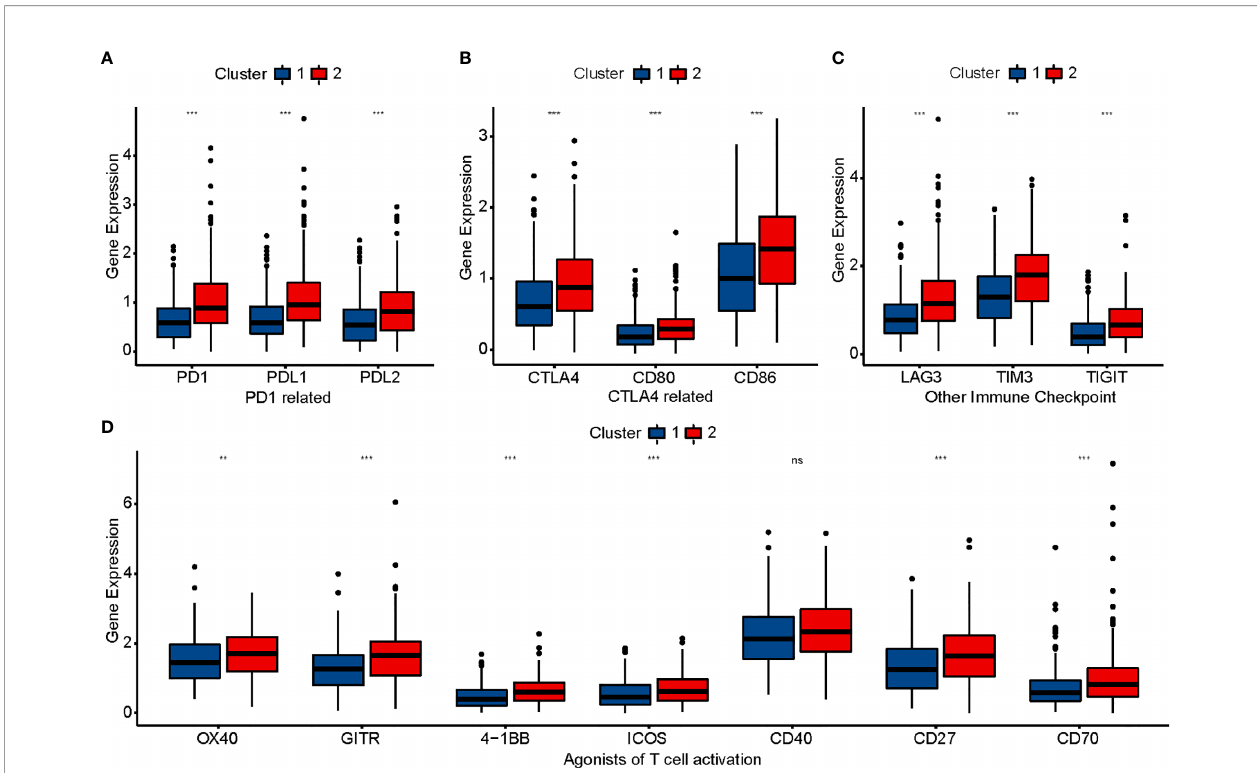
FIGURE 3 | Comparison of immunomodulatory drugs ’ targets in clinical trials for metastatic colorectal cancer between two clusters. The P values are labeled using asterisks (ns, no signi fi cance, **P < 0.01, ***P <